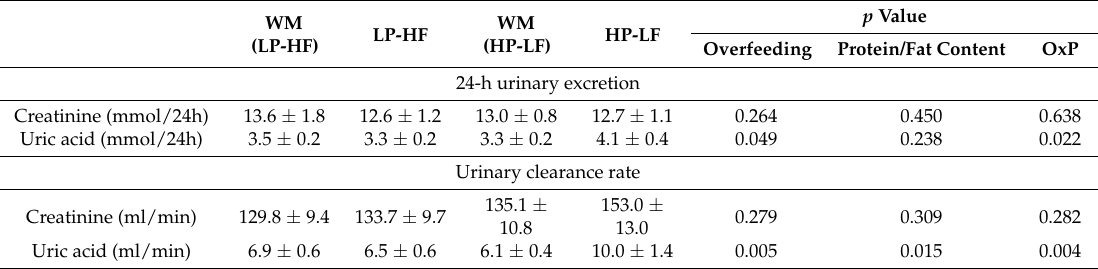
Table 4. 24-h urinary creatinine and uric acid excretion and